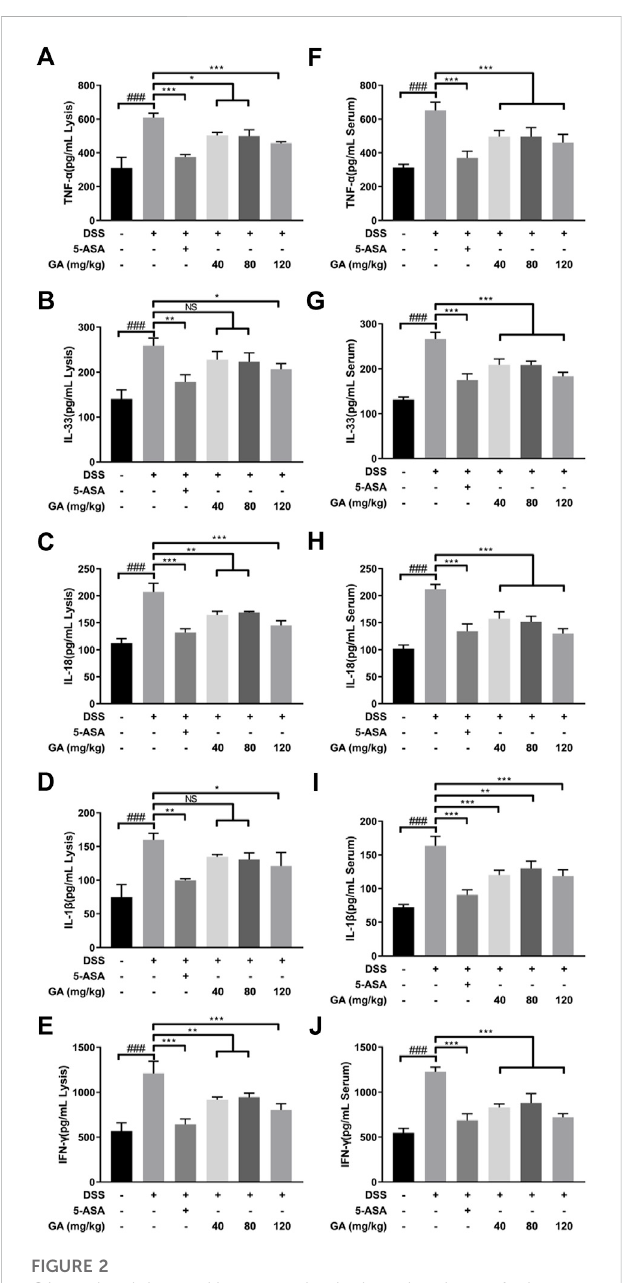
FIGURE 2 GA regulated the cytokine expression in the colon tissue of mice with DSS-induced colitis. The contents of (A) TNF- α , (B) IL-33, (C) IL-18, (D) IL-1 β , and (E) IFN- γ in the colon tissue and contents of (F) TNF- α , (G) IL-33, (H) IL-18 (I) , IL-1 β , and (J) IFN- γ in the serum of mice with DSS-induced colitis were determined using an ELISA kit. Data are mean ± SD. (n ≥ 3). ### p < 0.001 vs. Control group by t -test; * p < 0.05, ** p < 0.01, and *** p < 0.001 vs. DSS